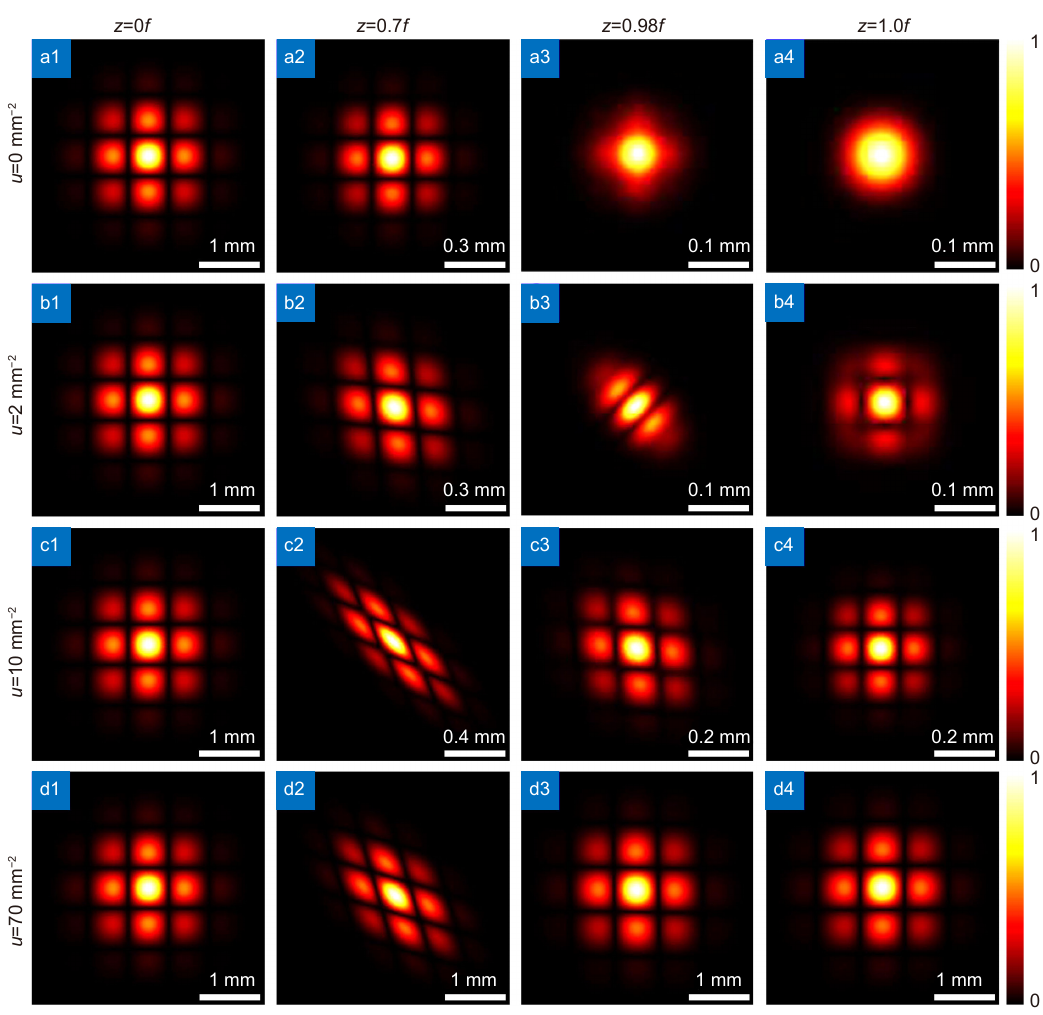
Fig. 1 | Variation of the modulus of DOC | μ | of a CGCSM beam with the propagation distance z after the focusing lens, with the CP strength factor ( a1 − a4 ) u = 0 mm −2 , ( b1 − b4 ) u = 2 mm −2 , ( c1 − c4 ) u = 10 mm −2 , and ( d1 − d4 ) u = 70 mm −2 . The parameters are set as λ = 532 nm, δ 0 =0.5 mm and n =1.